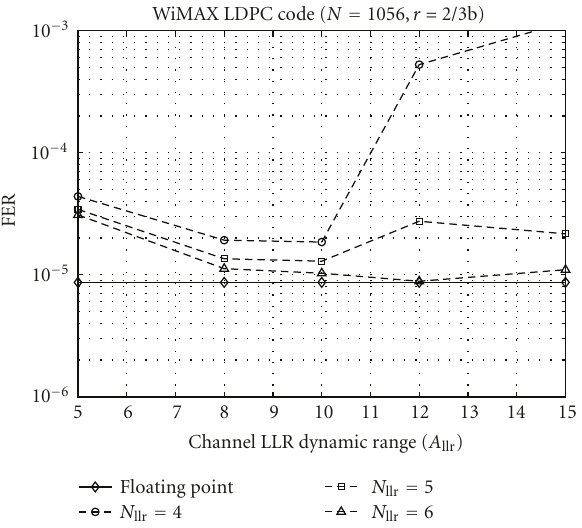
Figure 15: WiMAX LDPC code: e ff ects of the quantizationon input